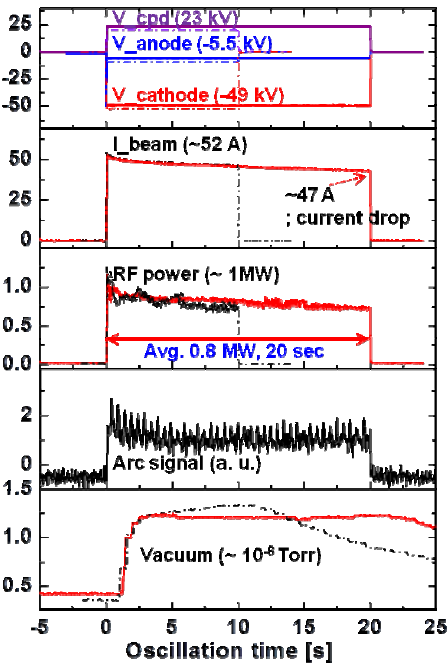
Fig. 3. Time evolution of 20 sec operation of the 170 GHz gyrotron at 1.0 MW. The efficiency is 40 % with depressed